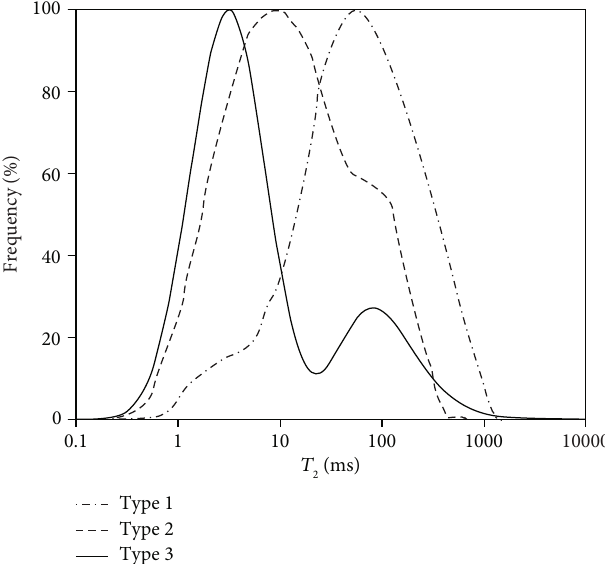
Figure 5: T 2 curves of the three typical samples.